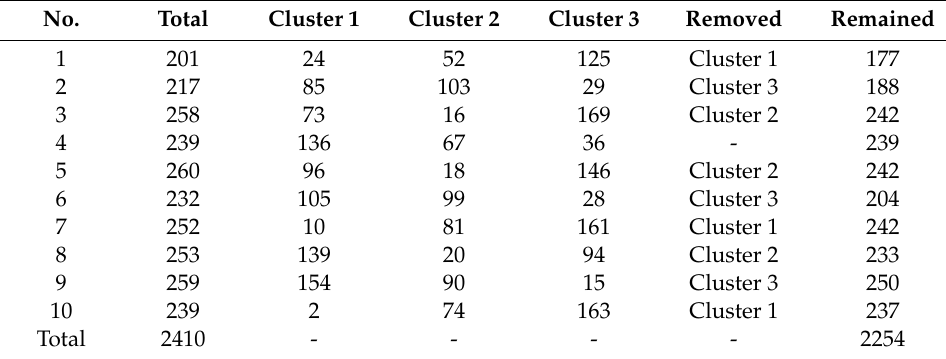
Table 3. Clustering results of spectrograms.